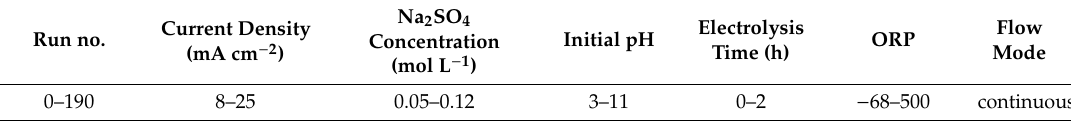
Table 1. Experimental conditions. ORP, oxidation–reduction